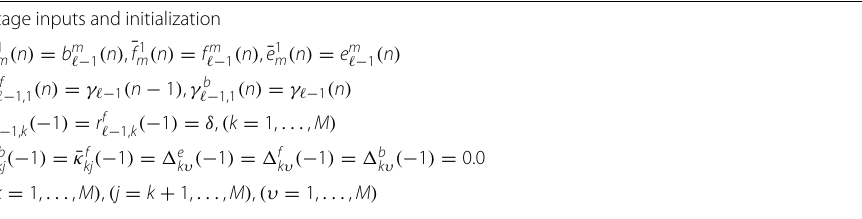
Table 1 The original SPMLS algorithm Stage inputs and